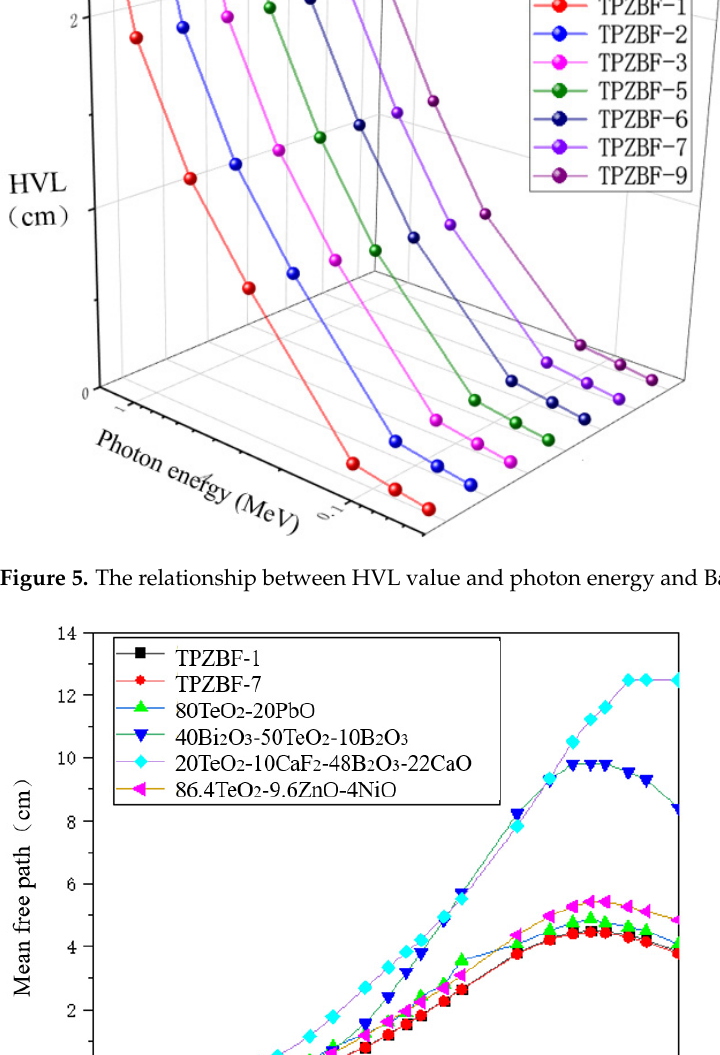
Figure 5. The relationship between HVL value and photon energy and BaF 2 content.